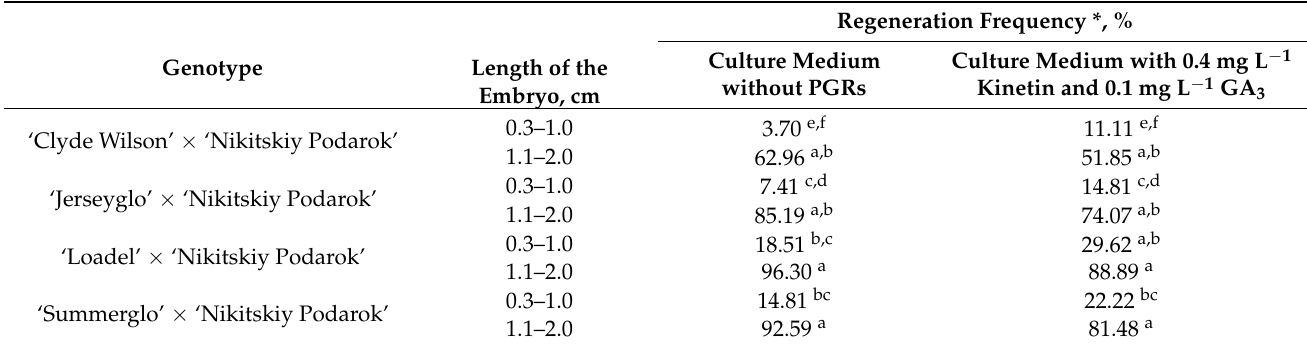
Table 2. Effect of genotype and embryo size on the plantlets formation from hybrid peach embryos on Monnier culture medium (90 days after initial culture).